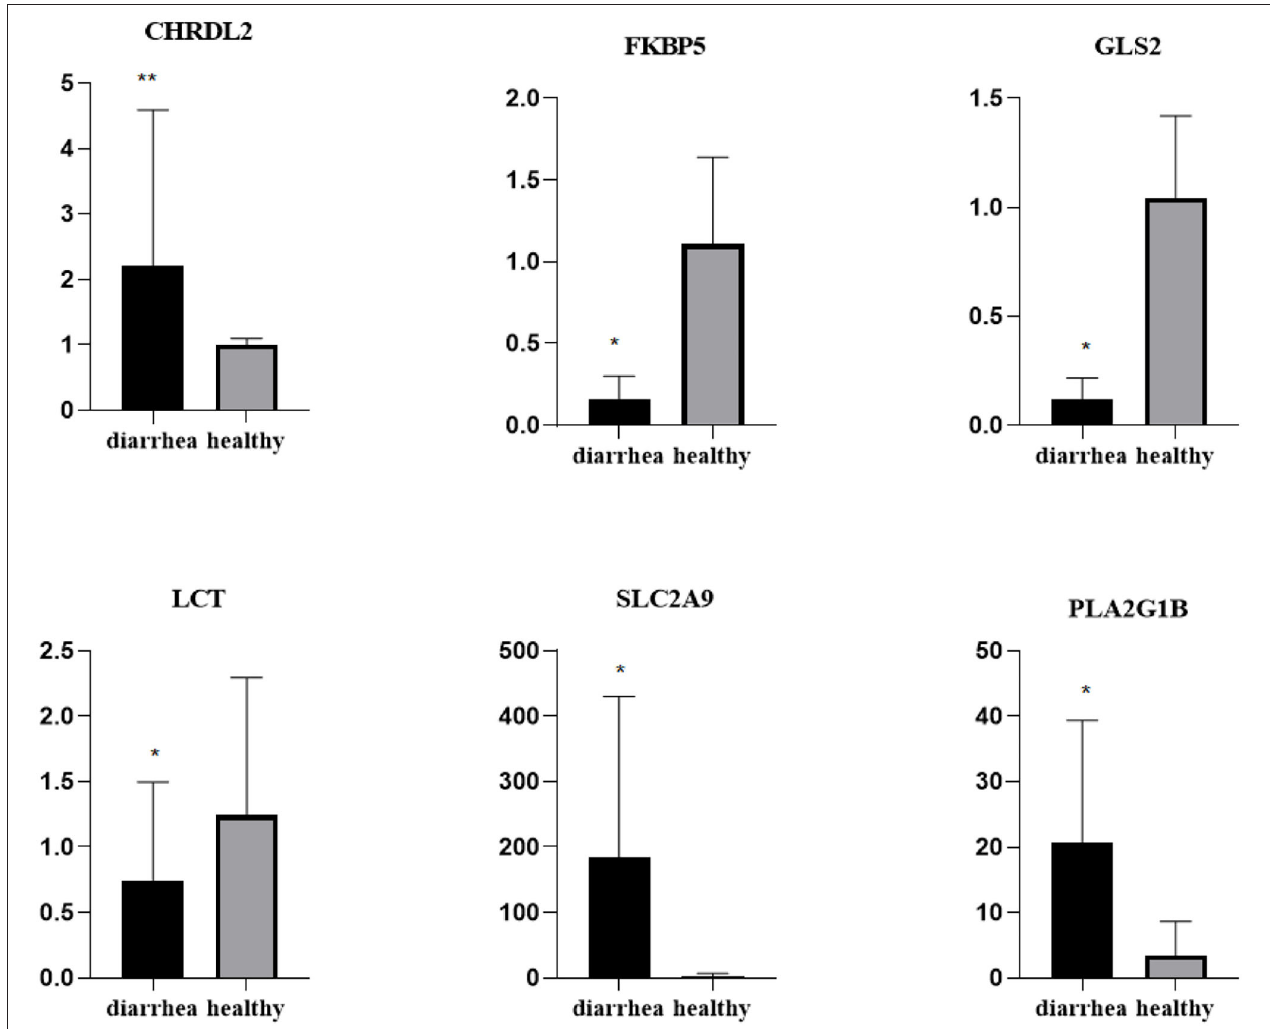
FIGURE 5 | Expression levels of genes CHRDL2, FKBP5, GLS2, LCT, SLC2A9, and PLA2G1B validated by RT-qPCR. The GADPH gene was used as an internal control, and the relative quantity of gene expression (fold change) of each gene was calculated with the comparative 2 − 11 CT method. Values (RT-qPCR) shown are mean with SD. *P < 0.05; **P <